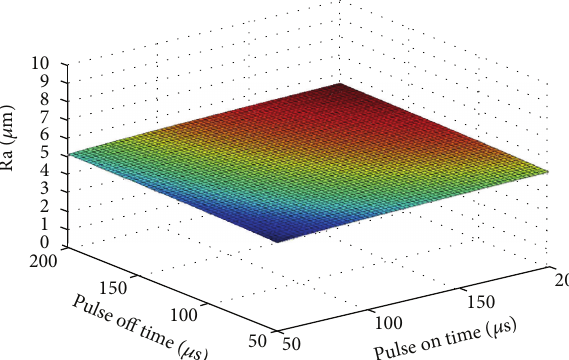
Figure 2: Effect of pulse on time and pulse off time on material removal rate (MRR) at current = 7.5A.